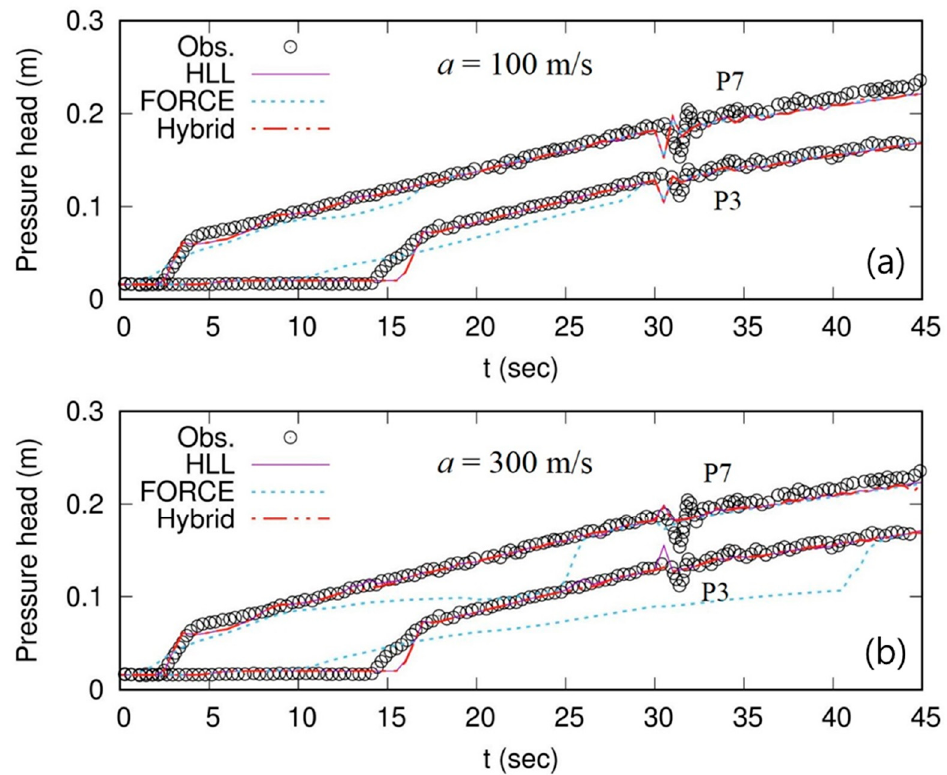
Figure 5. Observed and simulated pressure heads at 4.6 m (P3) and 0.6 m (P7) from the downstream sluice gate (Test 3) with ( a ) a = 100 m/s; ( b ) a = 300 m/s.